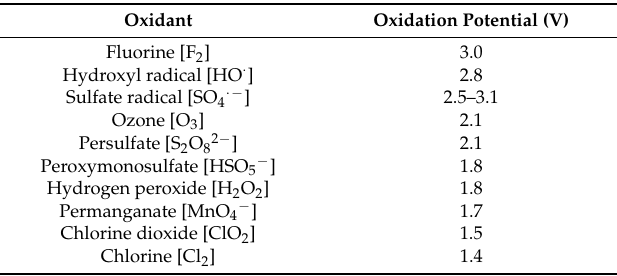
Table 1. Oxidation potential of commonly used oxidants